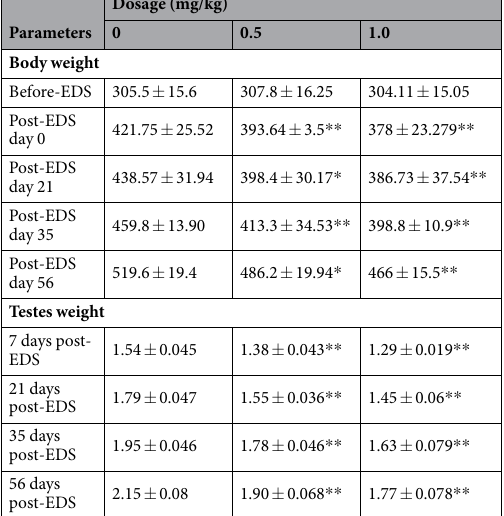
Table 1. General parameters of toxicology after treatment of CdCl and EDS Mean ± SE, n = 5. * P < 0.05, ** P < 0.01 indicate significant difference when compared to control (0 mg/kg) at each time